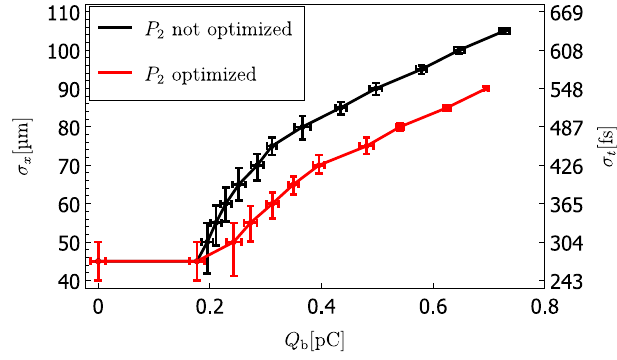
FIG. 15. Bunch length σ x to bunch charge Q second-harmonic buncher cavity P 2 is optimized for different bunch